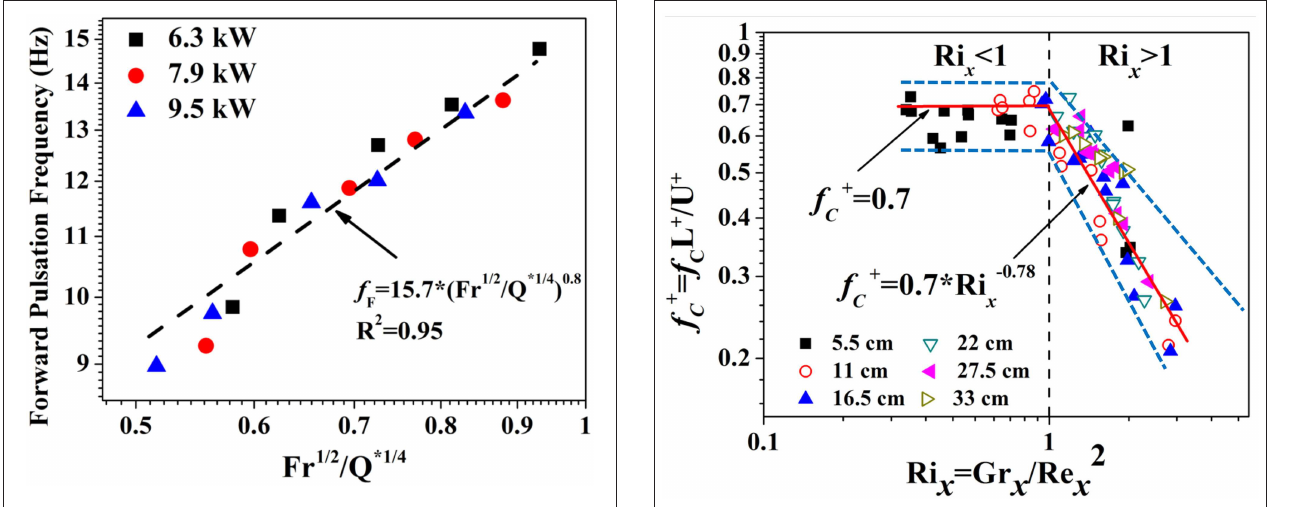
FIGURE 7 | Flame forward pulsation frequencies are found to scale with Fr 1 / 2 /Q* 1 / 4 .